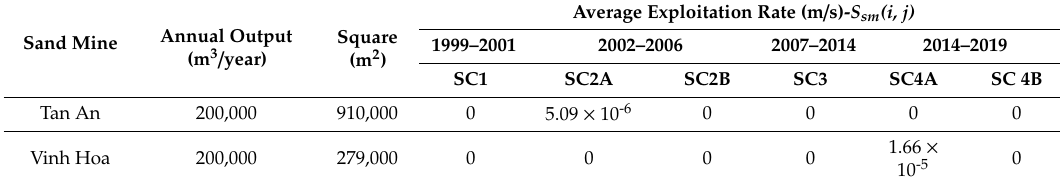
Figure 3. Tan An ( a ) and Vinh Hoa ( b ) sand mines position at Tien River. Table 1. Average exploitation speed of Tan An and Vinh Hoa sand mines.